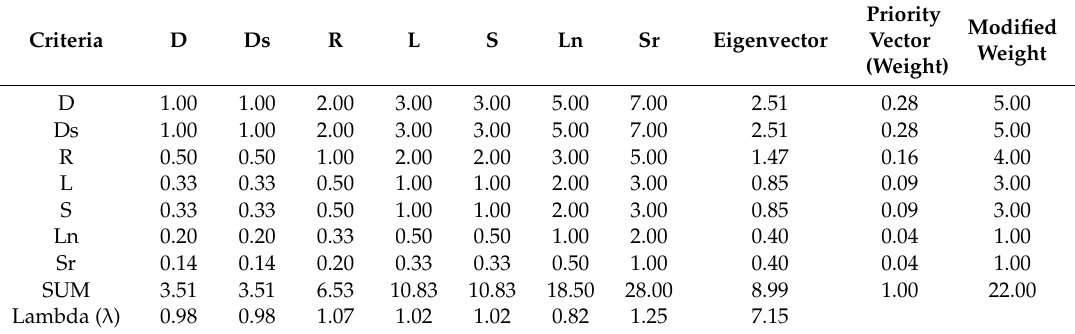
Table 14. Results of pairwise comparisons matrix for selecting suitable significance weights.